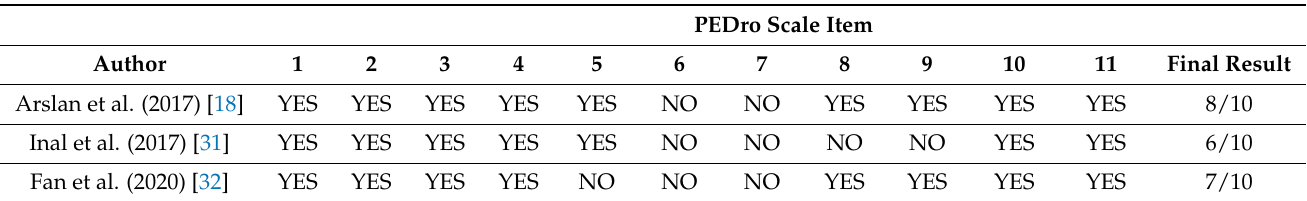
Table 4. Risk of bias according to the PEDro scale.